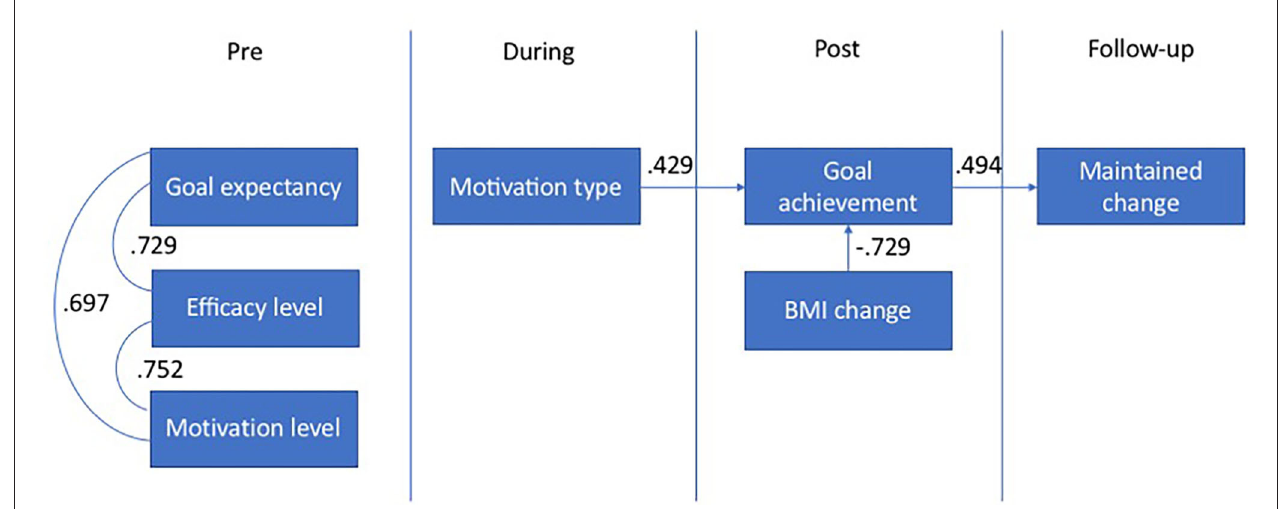
FIGURE 2 | Intervention timeline correlations.